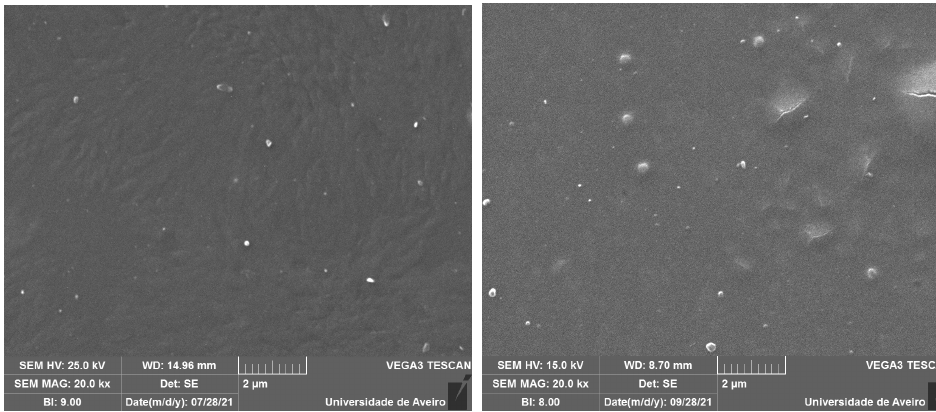
Figure 2. SEM micrographs of the 45S5 and Ce2 samples’ surfaces (magnification: 20.0 kx).